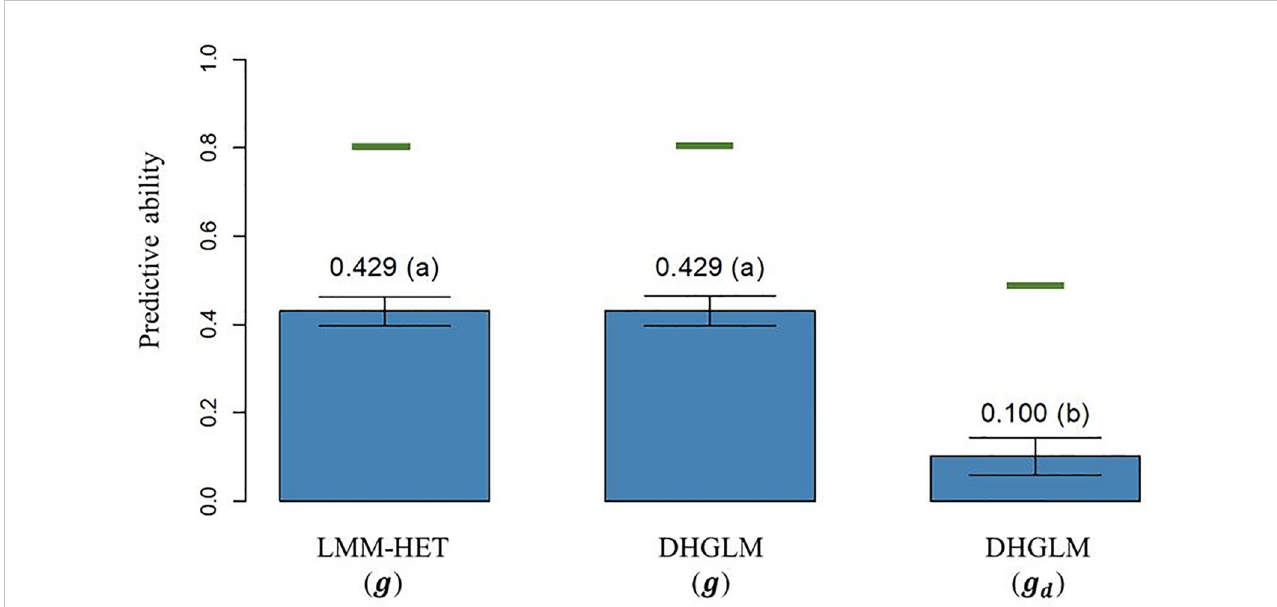
FIGURE 4 Predictive ability (PA) for the linear mixed model allowing heteroscedasticity of residual variance for the different environments (LMM-HET) and double hierarchical generalized linear model (DHGLM) in a leave-one-line-out (LOO) cross-validation. g : predicted additive genetic values for corrected phenotypes ( y c ). g d : predicted additive genetic values for dispersion variable ( y d ). Black bars represent the 95% con fi dence interval (CI) computed for each estimate as the standard deviation of the estimate multiplied by 1.96. The letter above the bar denotes signi fi cant differences between models in a t-test ( P-value < 0.01). The horizontal green lines represent the theoretical maximum